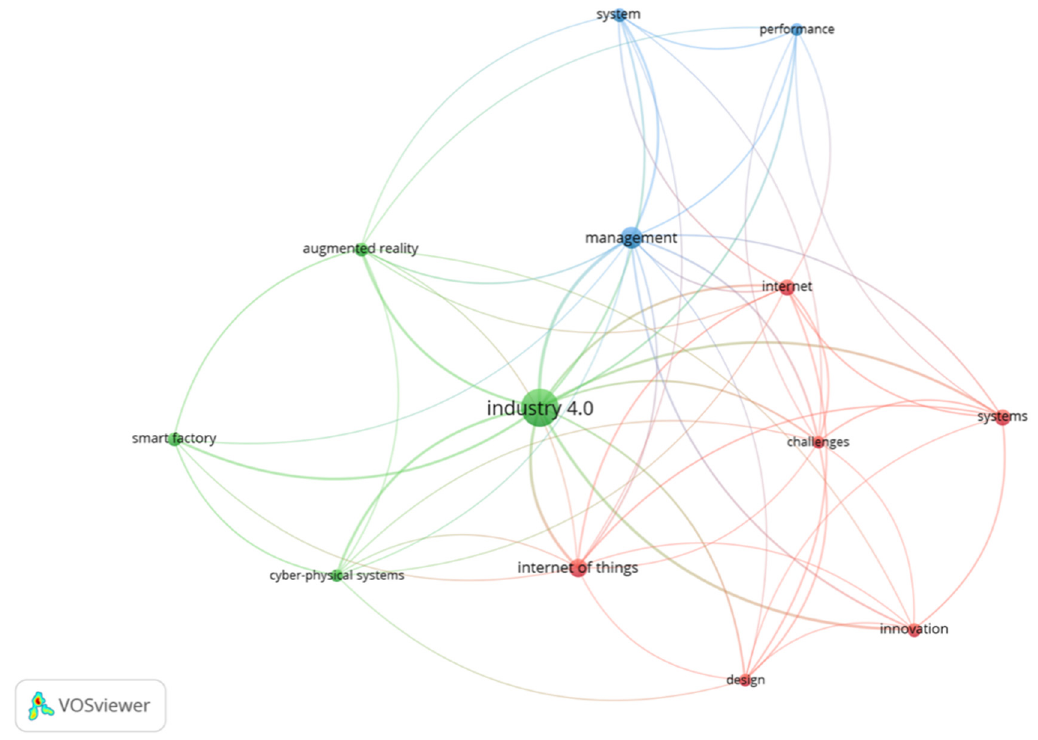
Figure 2. The most commonly co-occurring keyword search related to “Industry 4.0” OR “Industrial revolution 4.0” AND TOPIC “construction” OR “building” in Web of Science, with 183 publications.